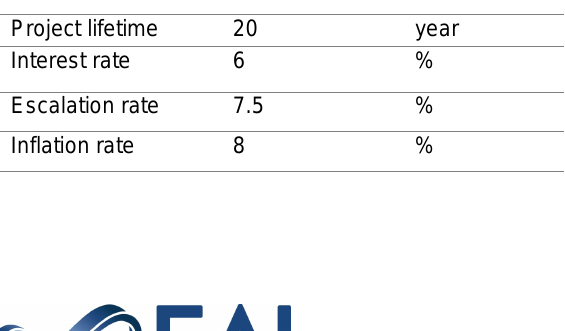
Table 4 . Battery